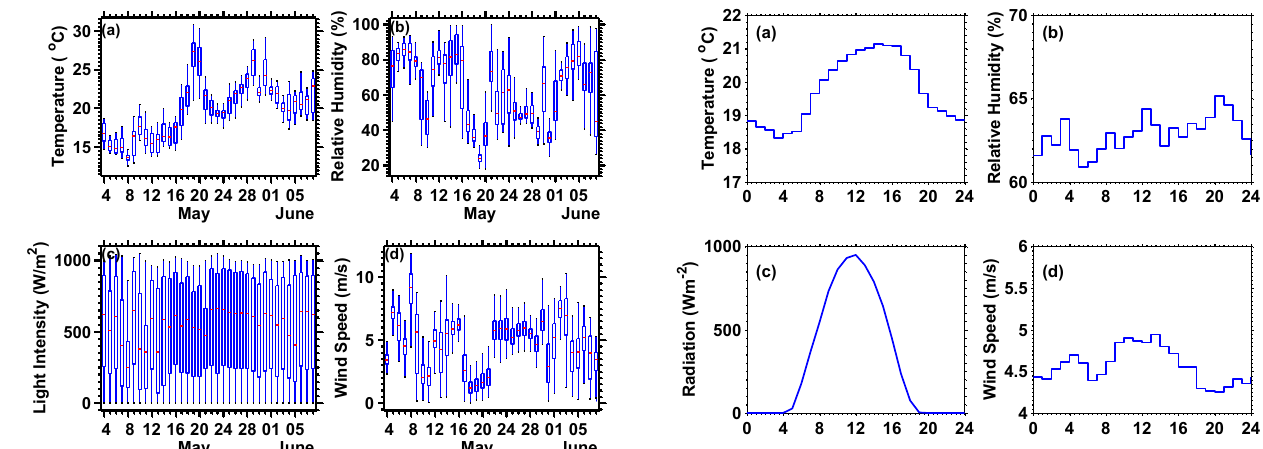
Fig. 4. Daily averages of: (a) ambient temperature, (b) relative humidity, (c) light intensity and (d) wind speed during 4 May to 8 June. Red lines indicate the median, boxes represent the upper and lower quartile and the whiskers extend to the most extreme data points. From 19 May to 21 May (source region Africa) average daily temperature increased and relative humidity decreased.